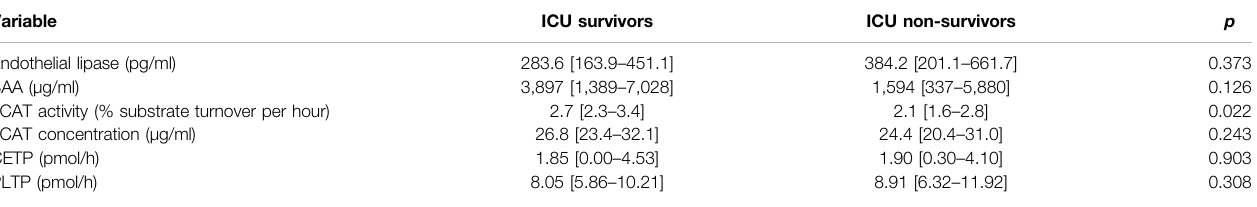
TABLE 2 | Lipid metabolism markers in survivors and non-survivor in the sepsis cohort. Abbreviations: ICU, intensive care unit; LCAT, lecithin-cholesterol acyltransferase; CETP, cholesteryl ester transfer protein; PLTP, phospholipid transfer protein; SAA, serum amyloid A.